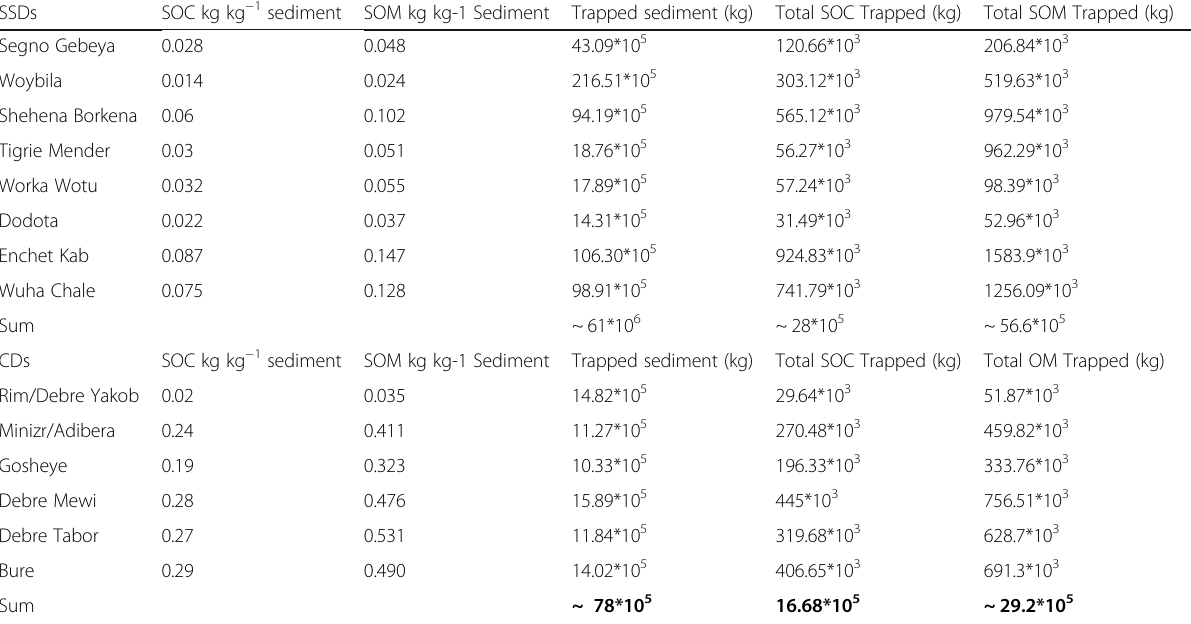
Table 3 SOC and OM trapped by SSDs and CDs SSDs